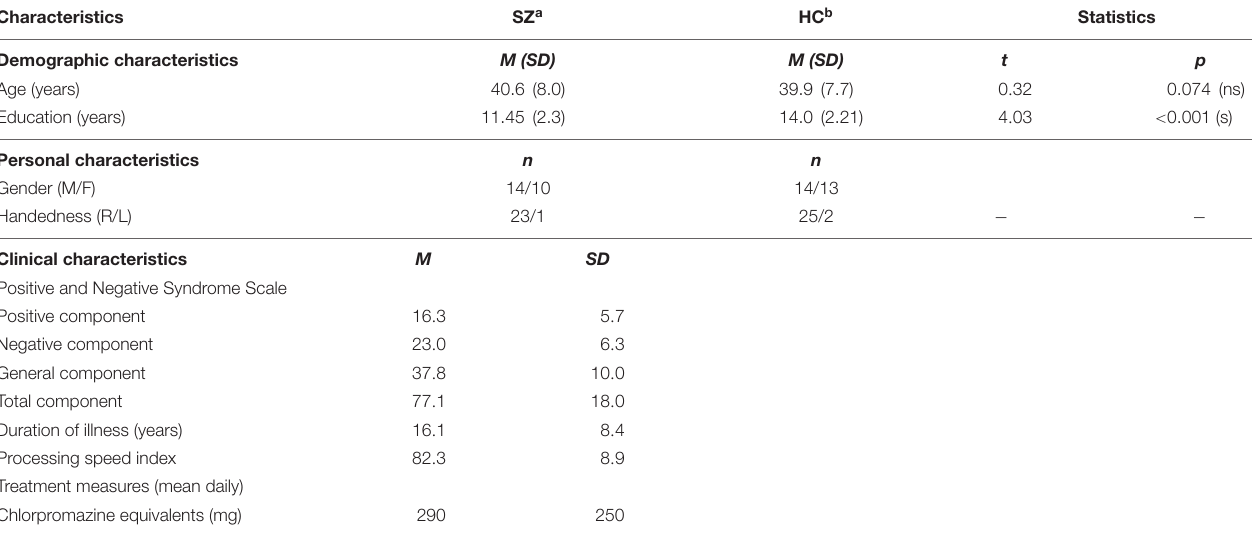
TABLE 1 | Demographic and psychometric characteristics for the patient and the control groups.